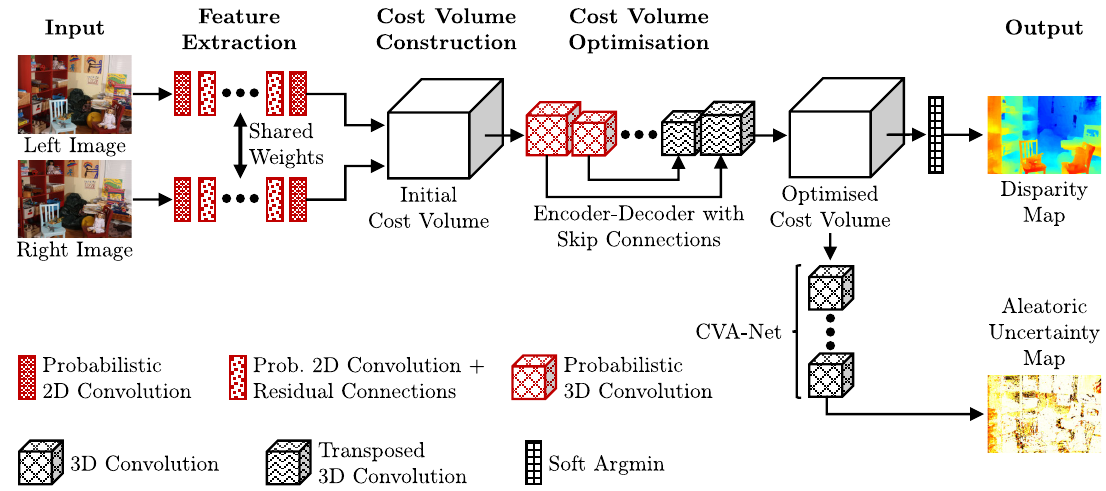
Figure 1. Overview of the functional model. While the probabilistic adaptation of the GC-Net architecture is trained to predict a disparity map corresponding to the left image of a planar rectified stereo image pair, the probabilistic convolutional layers further allow to estimate the corresponding epistemic uncertainty via Monte Carlo sampling. CVA-Net is integrated as a separate branch, operating on the optimised cost volume to additionally predict an aleatoric uncertainty map. Source: Adapted from Mehltretter